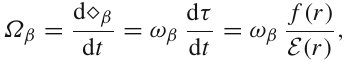
where ( f ( r )/ E ( r )) is the redshift coefficient, given by the function f ( r ) and the particle specific energy at the circular orbit E ( r ) . If the fundamental frequencies of the small har- monic oscillations related to the distant observers, Ω β , are expressed in the physical units, their dimensionless form has to be extended by the factor c 3 / GM . Then the frequencies of the charged particle radial and latitudinal harmonic oscil- lations measured by a distant observer in physical units